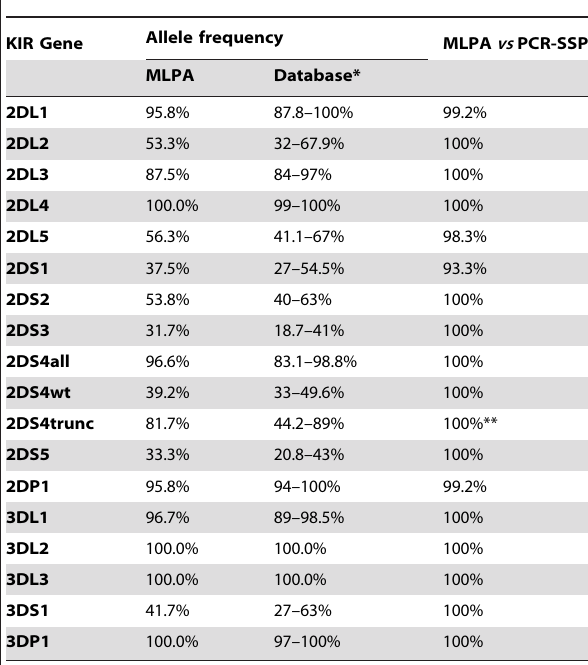
Table 1. KIR genotype frequency as determined by MLPA, compared with data from the allele frequency database and determination by